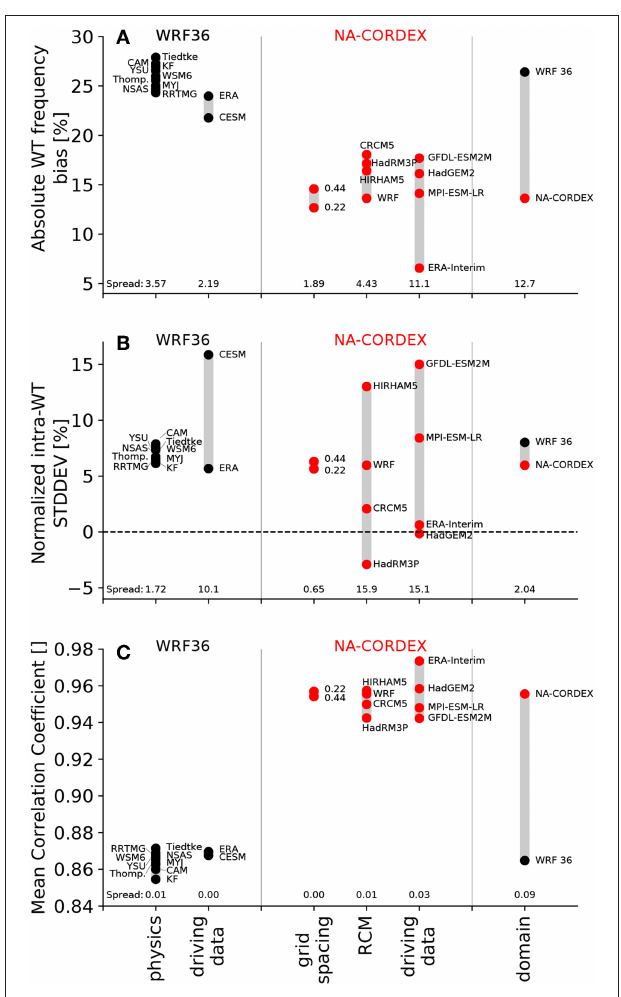
FIGURE 9 | Estimates of WT skill variability for different drivers using three metrics: (A) absolute WT frequency biases, (B) normalized intra-WT standard deviations, and (C) mean centroid pattern correlation coefficients. The impact of model physics and driving data is investigated in the WRF36 simulations (black symbols). The effect of horizontal grid spacing, RCM, and driving data is assessed for the NA-CORDEX simulations (red symbols). The impact of the domain size is estimated comparing WRF simulations in the NA-CORDEX ensemble with WRF36 runs. The maximum minus minimum spread is shown on the bottom of each